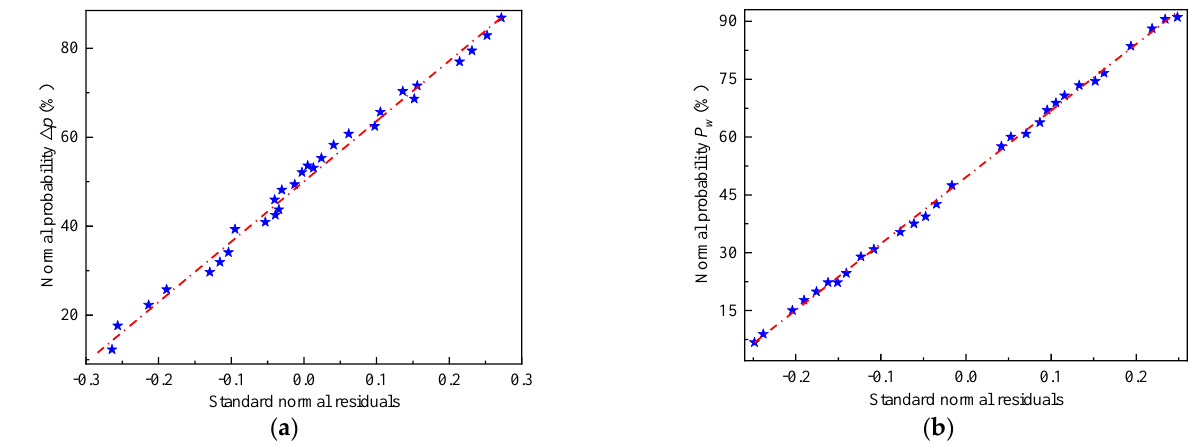
normal distribution line, which confirms that the analysis data from the population of normal distribution.